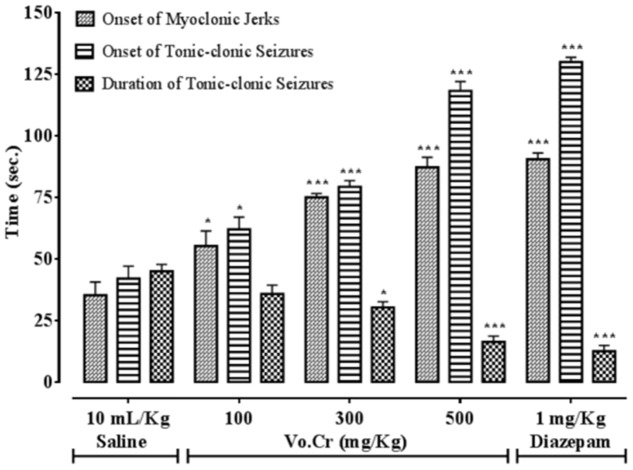
Bar-graph showing effects of Verbena officinalis crude extract (Vo.Cr) and diazepam on onset time of pentylenetetrazole-induced myoclonic jerks, tonic-clonic seizures and duration of tonic-clonic seizures in mice. Data expressed as mean ± SEM, n = 4. ∗P < 0.05, ∗∗∗P < 0.001 vs. saline group, one-way ANOVA with post hoc Tukey test.